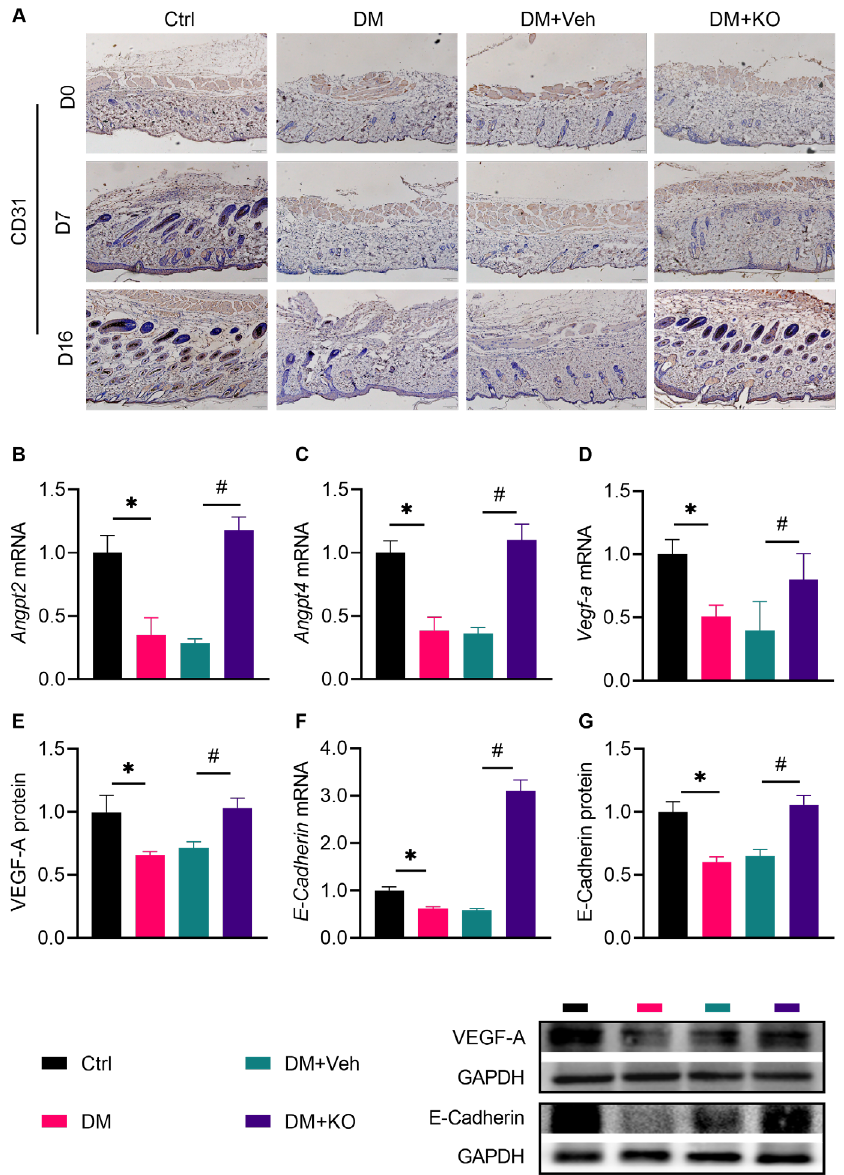
Figure 7. KO enhanced neoangiogenesis in the diabetic wounds. ( A ) IHC staining of CD31. The ( B ) Angpt2 mRNA levels, ( C ) Angpt4 mRNA levels, ( D ) Vegf-a mRNA and ( E ) protein levels, ( F ) E-Cadherin mRNA, and ( G ) protein levels were determined. The data were summarized as means ± SD. *, p < 0.05 vs. Ctrl; #, p < 0.05 vs. DM. Angpt2 , Angiopoietin-2; Angpt4 , Angiopoietin-4; VEGF-A, Vascular Endothelial Growth Factor A. The other abbreviations are the same as in Figures 3 and 6.